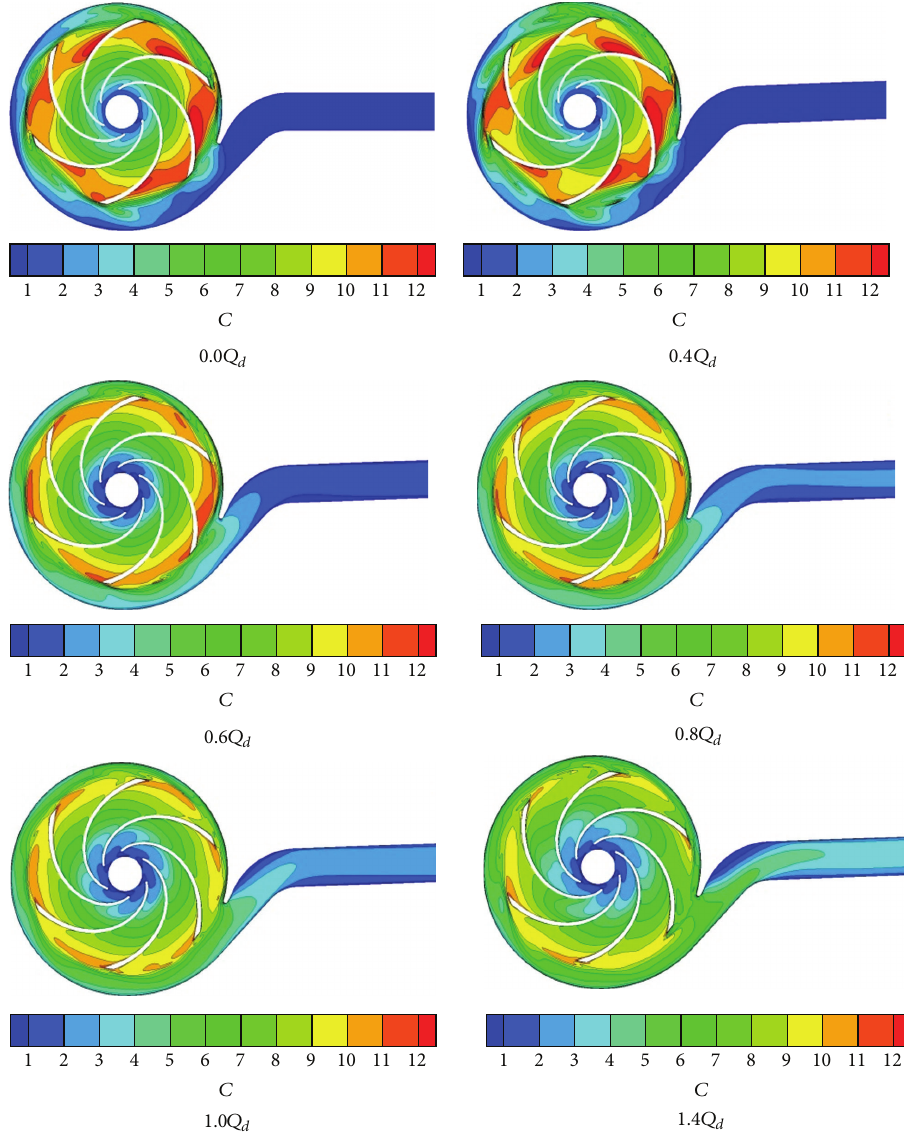
Figure 9: Absolute velocity at different flow